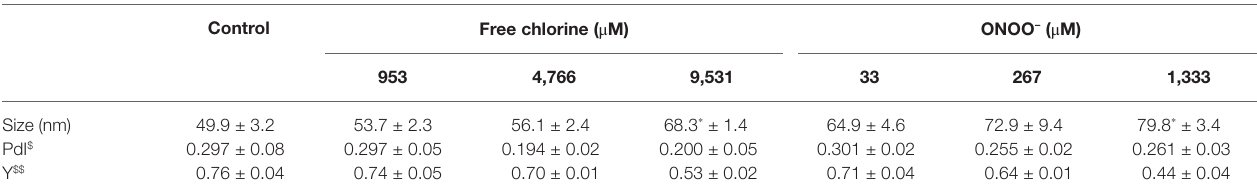
TABLE 1 | Size of GII.4 VLPs after oxidative treatments defined by DLS.